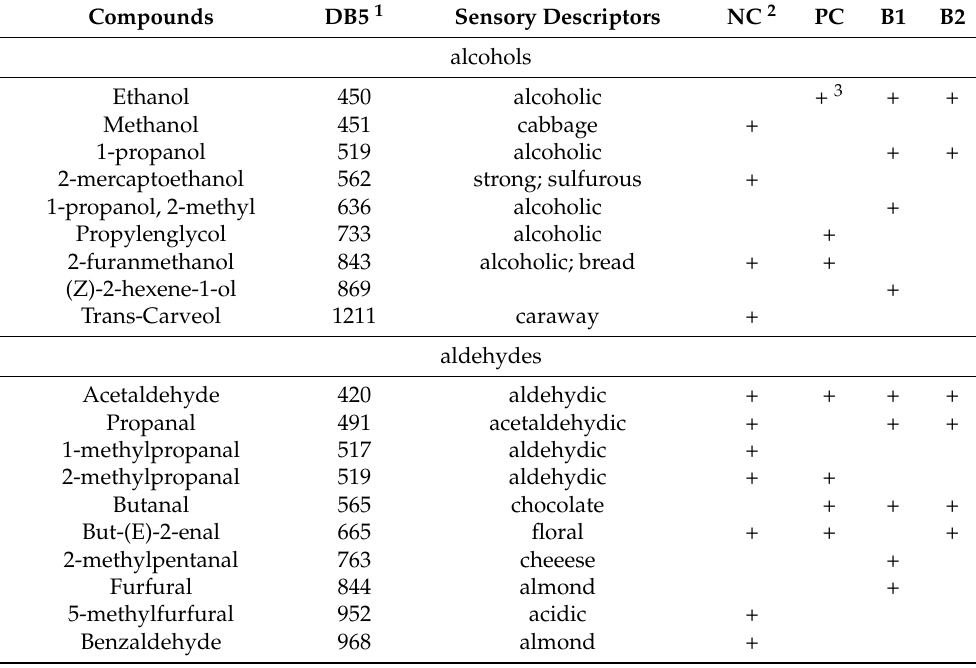
Table 3. Volatile compounds’ characteristic of pork loins cured with alternative nitrite sources.